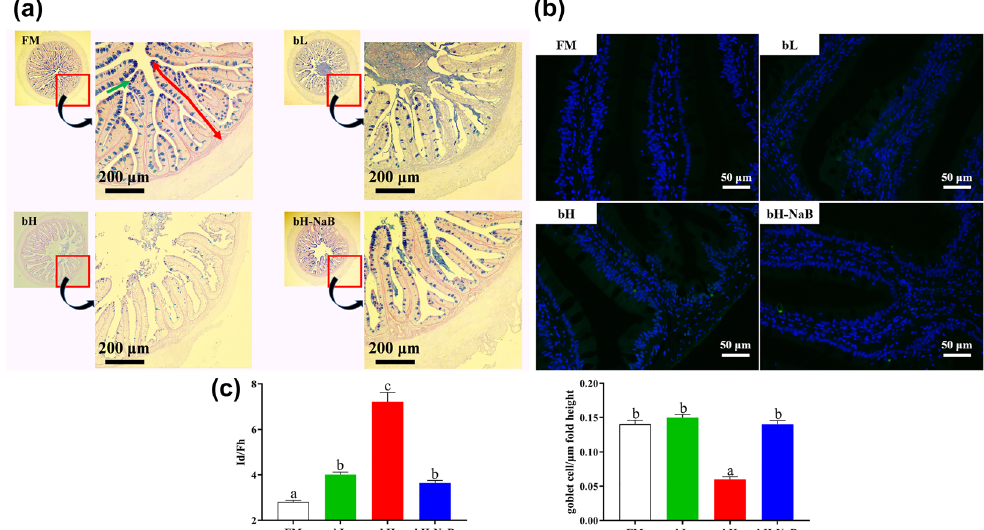
Figure 3. Distal intestinal histological evaluation based Alcian Blue-Periodic acid-Shiff staining ( a ) and TUNEL staining ( b ) of distal intestine sections obtained from juvenile hybrid grouper fed experimental diets for 8 weeks. Green arrow: goblet cell; red arrow: fold height. Results are represented as the means ± SE (n = 8) ( c ). Significance was evaluated by one-way ANOVA followed by Tukey multiple range tests. FM control diet, bL containing 1.5% 7S diet, bH containing 6% 7S diet, bH-NaB containing 6% 7S and 0.13% NaB diet. a,b,c Mean values denoted by different superscripted letters differ significantly at the P < 0.05 level ( P < 0.05).